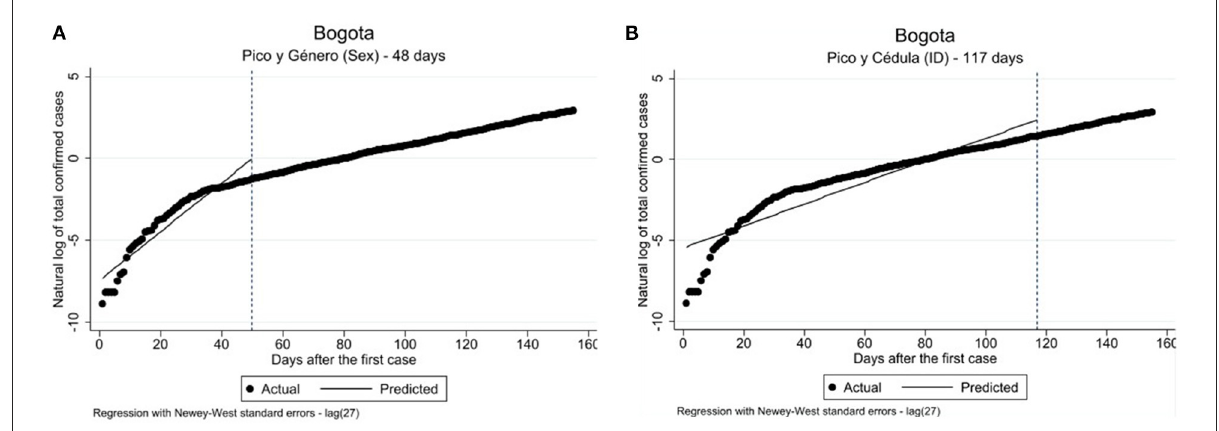
FIGURE2 (A) Single ITSA predicting the effect of peak and sex/peak and id on the COVID-19 infection rate, by city; the interruption time-point of the analysis is 14 days after the actual implementation of the policy. (B) Single ITSA predicting the effect of peak and ID on the COVID-19 infection rate in Bogota; the interruption time-point of the analysis is 14 days after the actual implementation of the policy.